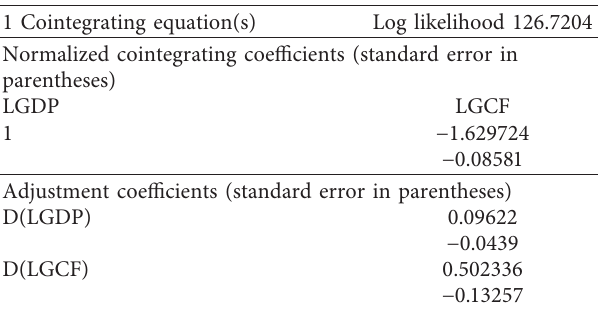
Table 4: Normalized long-run coefficient of LGDP and LGCF.